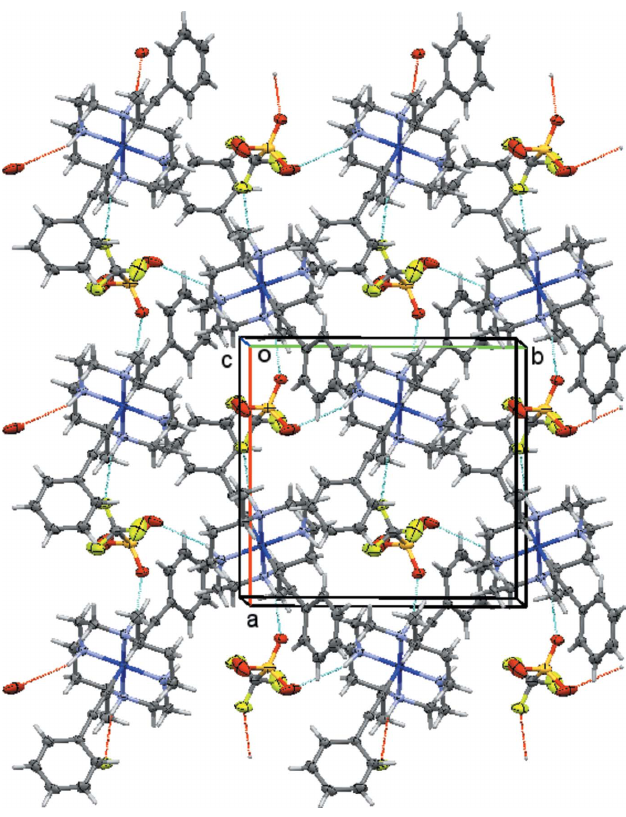
Hydrogen-bonding interactions in 2 , showing the hydrogen-bonded layer formed by cations and anions of Co2 and S2, respectively. Hydrogen bonds are depicted as dashed turquoise lines. View is slightly tilted down the c